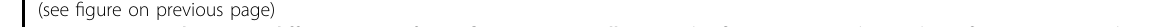
Table S1). Blood samples of breakthrough infection con-